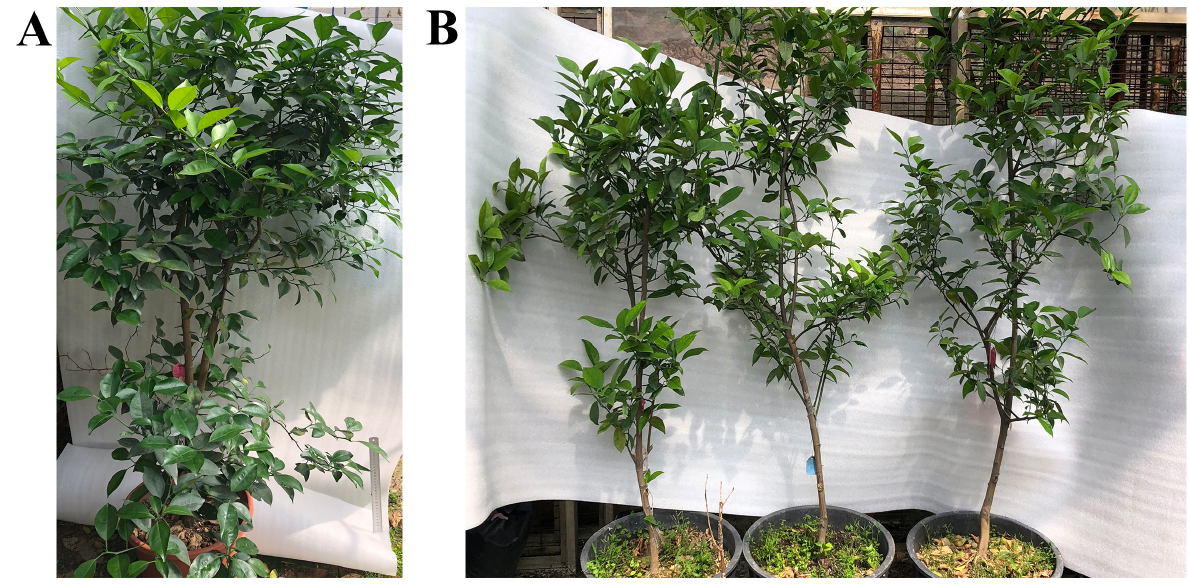
Figure 3. Phenotypes of transgenic plants after four years. ( A ). transgenic miR171b plants without HLB. ( B ). Transgenic miR171b plants with HLB. Non-transgenic plants with HLB died prior to four years after